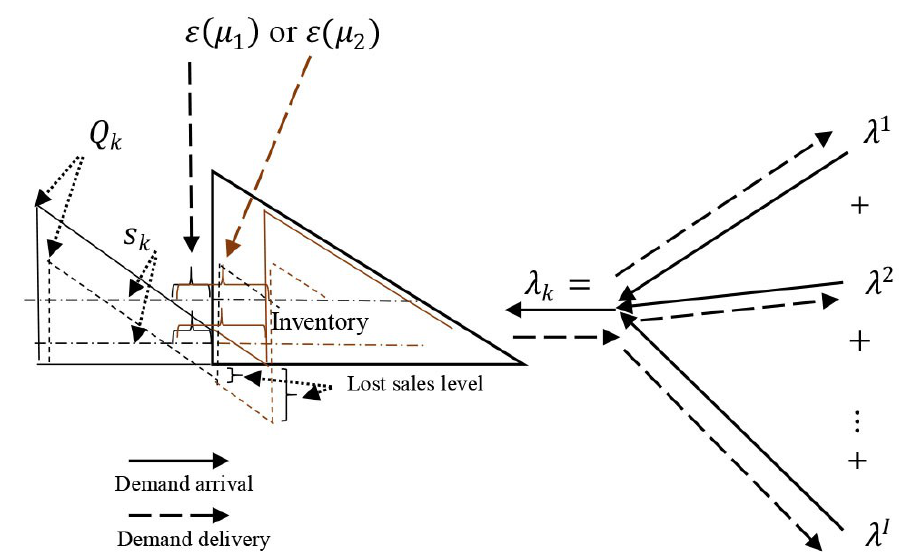
Figure 2. Q k , s k , λ k dependent inventory accumulation, and stochastic demand arrival and delivery process in a warehouse ( k